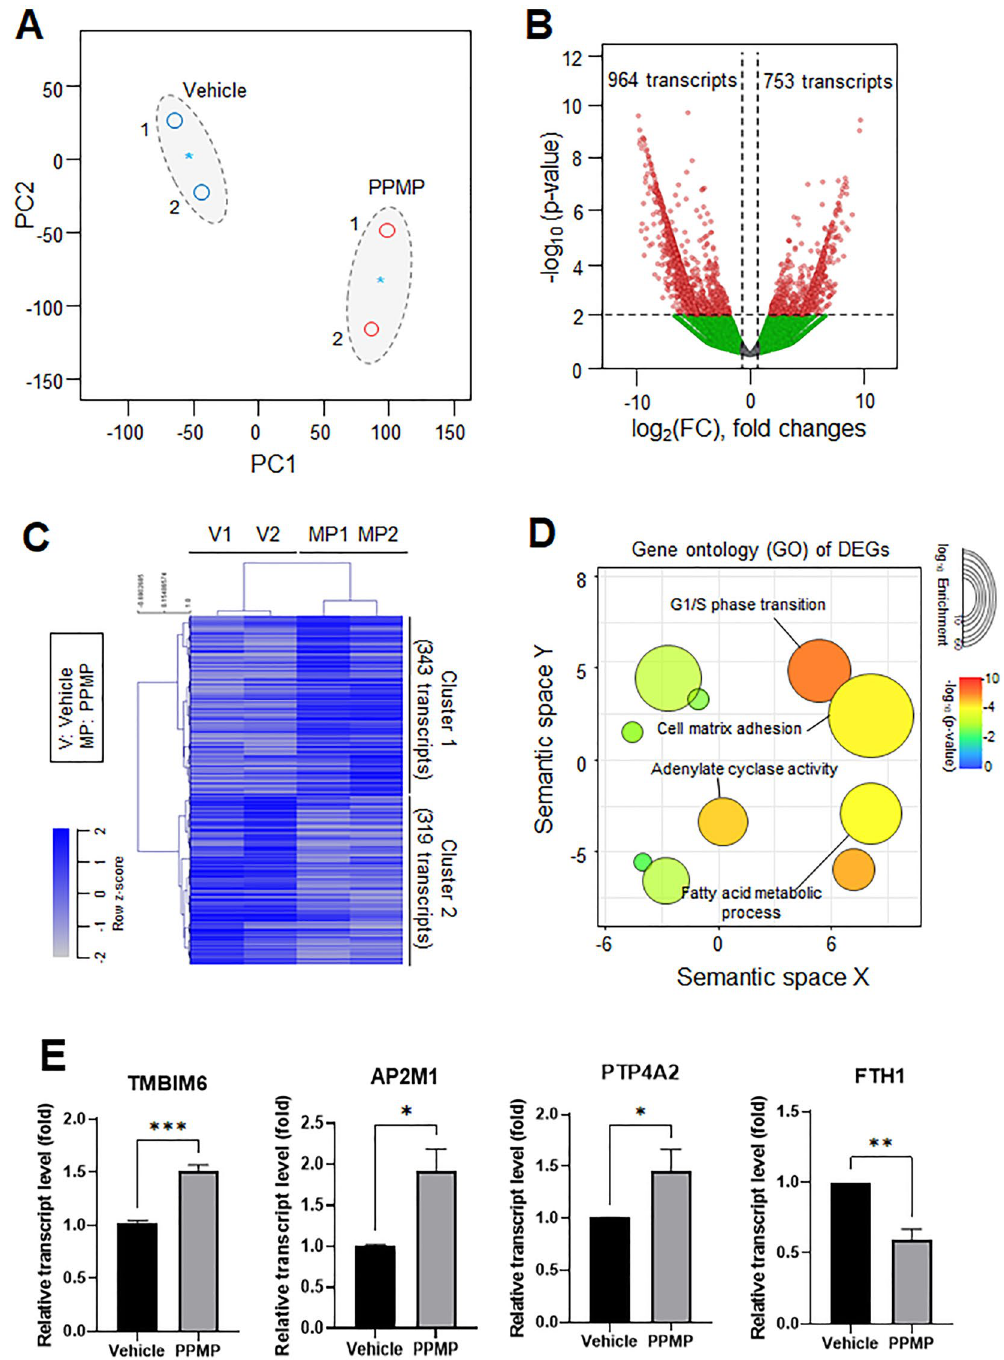
Figure 4. Transcriptomic dynamics in PPMP-treated MDA-MB-231 cells. The common gene expression patterns through two independent experiments were identified by transcriptomic analysis using the RNA-seq platform. ( A ) Principal component analysis (PCA) of the RNA-seq analysis. The values indicate the amount of variation attributed to each principal component. The small circles indicate individual samples, blue asterisks indicate the average between experimental replicates, and larger gray ovals represent each experimental group. ( B ) The volcano plot from the filtered significant DETs from the MDA-MB-231 cells with or without the PPMP incubation. ( C ) The differential gene expression patterns of DETs in the RNA-seq analysis. The hierarchical clustering of genes (rows) and experimental samples (columns) from the RNA-seq data. ( D ) The top enriched GO cellular components and biological processes of PPMP-treated cells, visualized from the significantly upregulated DETs from the RNA-seq platform. The size of the circle represents the enriched genes, and the color represents − log 10 of the p -value. ( E ) Transcript levels of TMBIM6, AP2M1, PTP4A2, and FTH1 were evaluated by qRT-PCR in MDA-MB-231 cells (unpaired two-tailed t test, * p < 0.05, ** p < 0.01, *** p < 0.001 relative to the vehicle